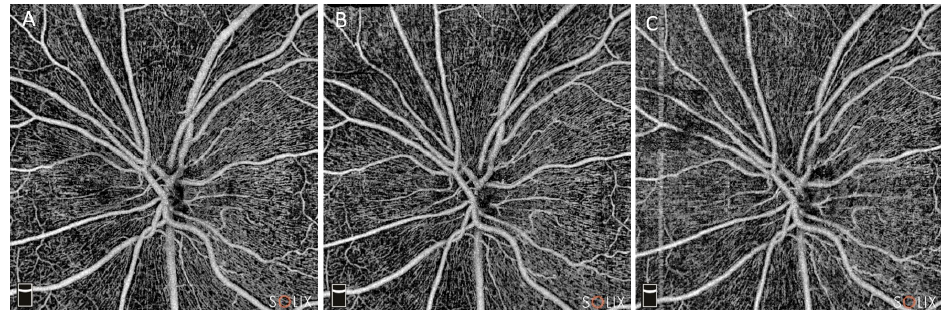
Figure 1. AngioVue Retina images of macular vascularization during the follow ups, in 6.4 × 6.4 mm scans. Upper images highlight the superficial capillary plexus (SCP): baseline ( A ), one week after cataract surgery ( B ) and one month after surgery ( C ). At last follow up, a significant increase in both whole image and foveal vascular density were reported (from 48.3% at T0, to 48.4 at T7, to 51.9% at T30). Similarly, the lower images show the deep capillary plexus (DCP) evolution at T0 ( D ), T7 ( E ) and T30 ( F ). DCP vascular density improved from 50.1% at T0, to 49.8% at T7 and finally to 54.0% at T30.